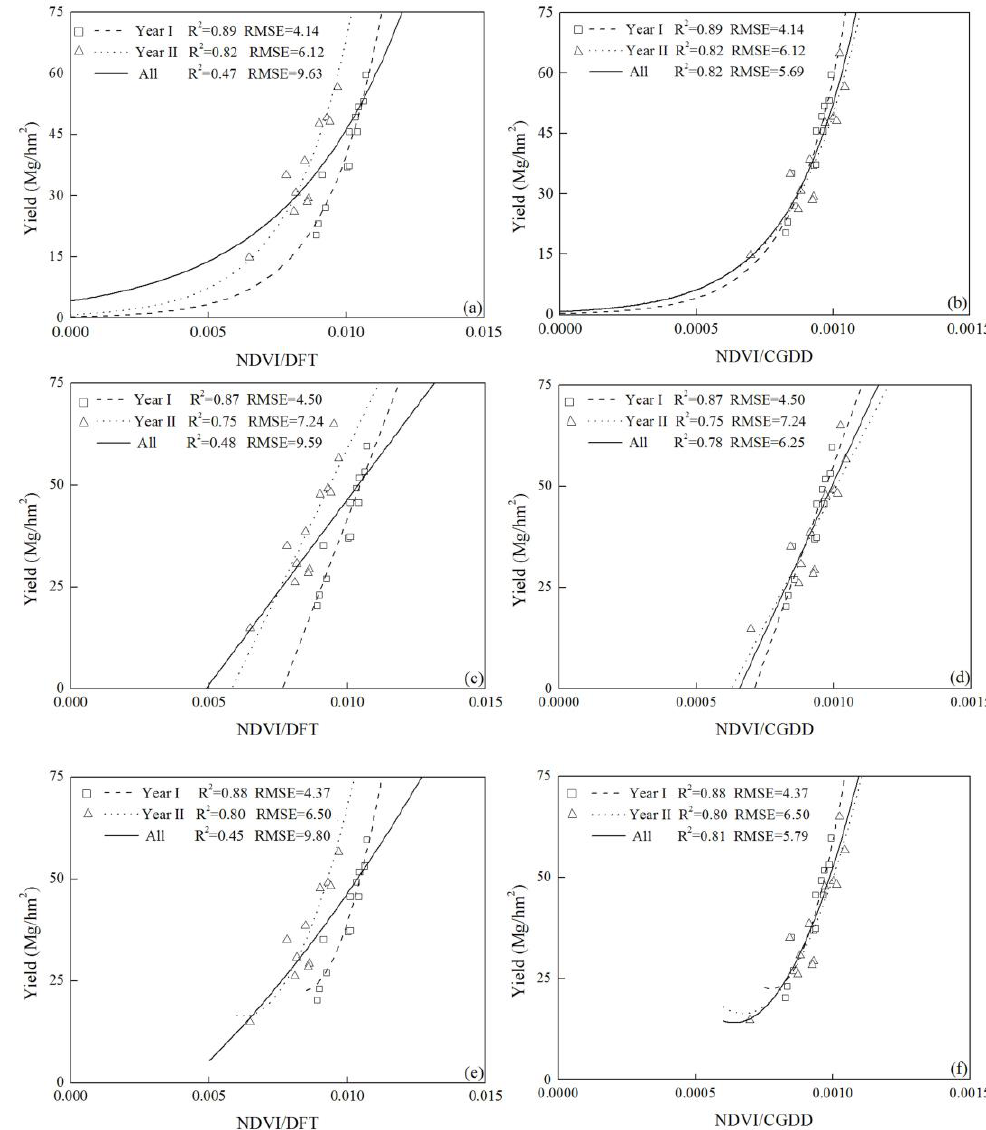
Figure 5. Using the DFT and CGDD values to modify the exponential: ( a ) and ( b ), linear: ( c ) and ( d ), and quadratic: ( e ) and ( f ) yield prediction equations, respectively. The data presented in the figure was obtained from the result of JB cultivar in year I and II. The DFT and CGDD values represent the number of days from transplanting to sensing where GDD (growing degree days) > 0) and the cumulative growing degree days from transplanting to sensing, respectively.